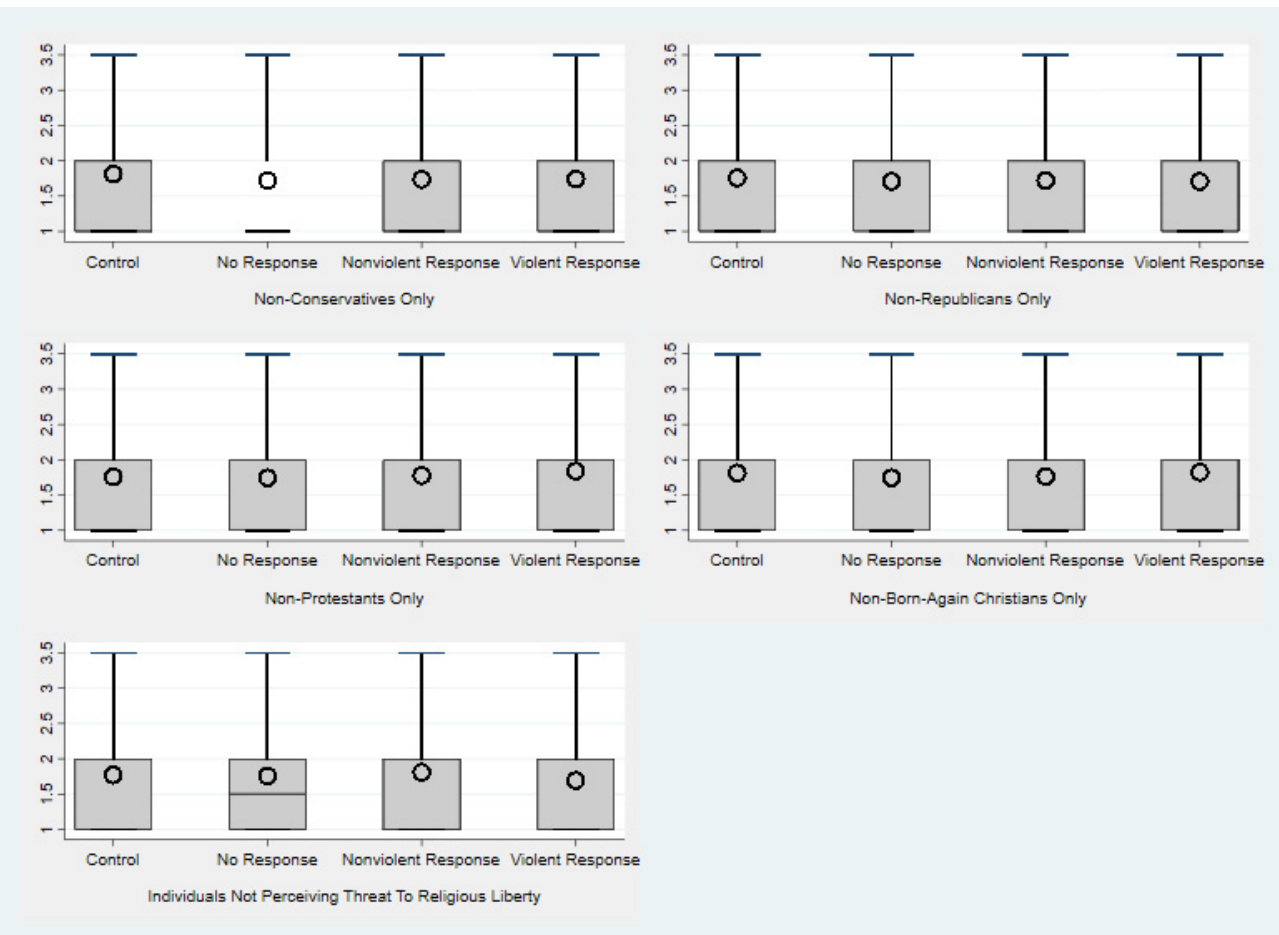
Figure A2. The causal effects of persecution discourse on support for political violence across conditions and by additional subsample. The top left panel illustrates the effects of persecution discourse on the non-conservative (i.e., liberal and other) subsample’s support for political violence. The top right panel illustrates the effects of persecution discourse on the non-Republican (i.e., Democrat and other) subsample’s support for political violence. The middle-left panel illustrates the effects of persecution discourse on the non-Protestant subsample’s support for political violence. The middle-right panel illustrates the effects of persecution discourse on the non-born-again Christian subsample’s support for political violence. The bottom left panel illustrates the effects of persecution discourse on the non-religious liberty threat perception subsample’s support for political violence.